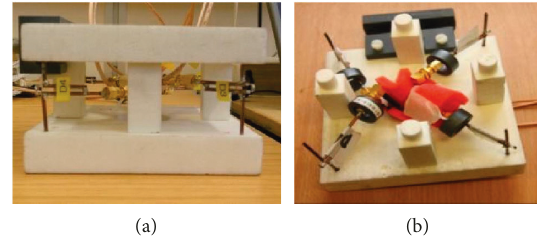
Figure 14: Rohacell material has been constructed as the sup- porting structure to the antenna array (a) side view and (b) the top view.